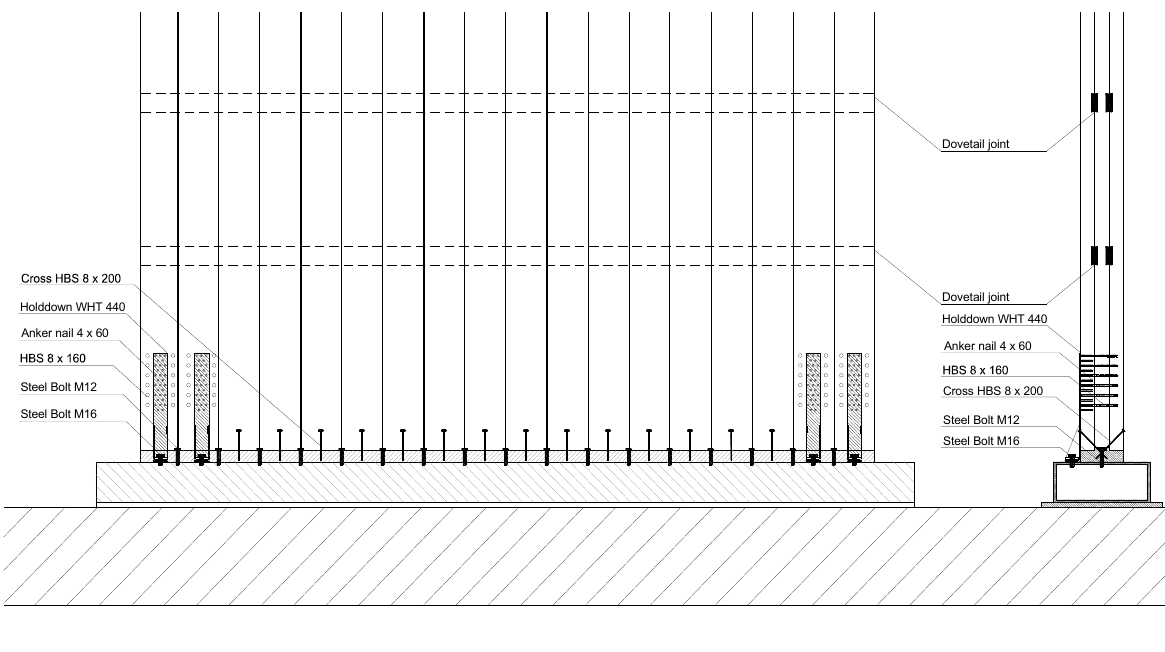
Figure 5. Wall C: Connections to foundation and dovetail joints.